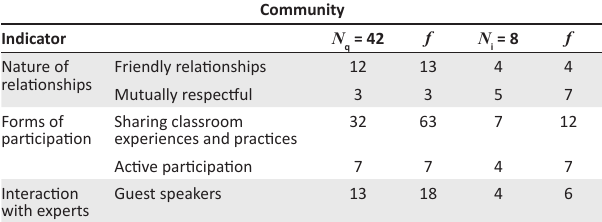
TABLE 3: Utterances of Numeracy Inquiry Community of Leader Educators’ community-related affordances.